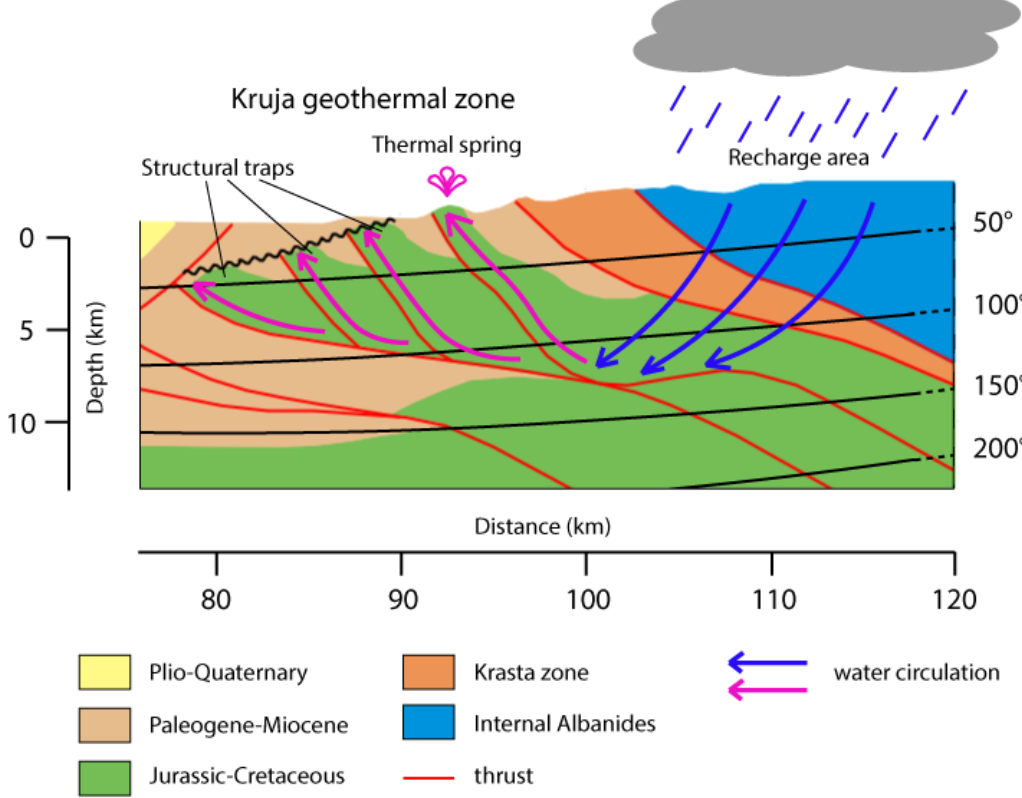
Figure 11. Detail of the regional cross-section, showing a conceptual model of fluid migration pathways controlling the “Kruja geothermal zone”.